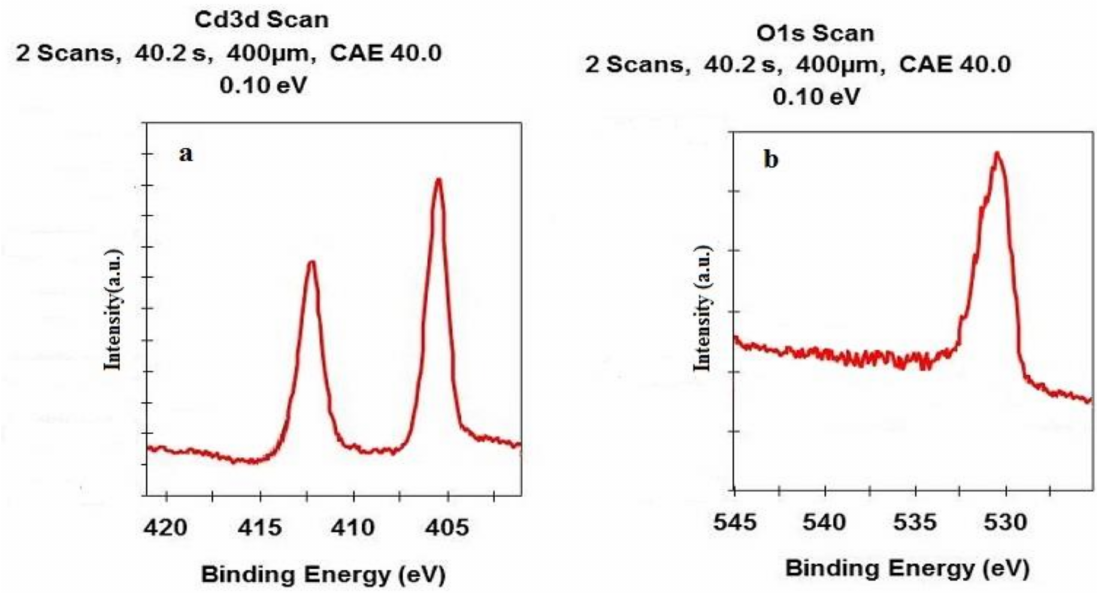
Figure 10. CdO XPS spectra ( a ) Cd scan and ( b ) O scan obtained by thermolysis of 1 . The thermal gravimetric (TG) analysis was applied to evaluate the thermal stability of the [Cd(L)(NO 2 ) 2 ] n 1 . TG was recorded in the temperature range of 20 and 800 ◦ C. The